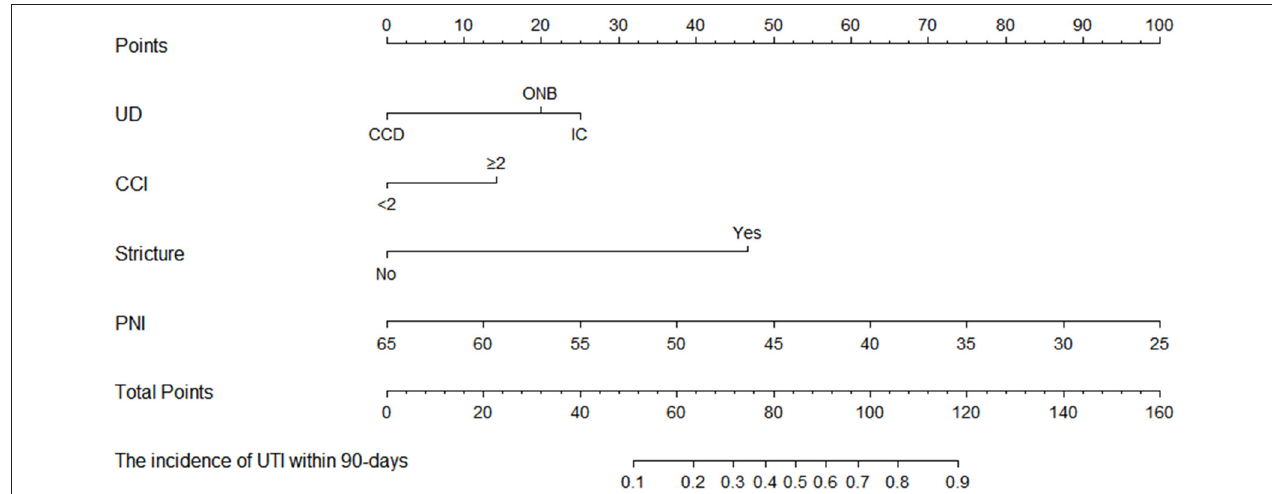
FIGURE 4 | Receiver operating characteristic (ROC) and decision curve analysis (DCA) curve in the training and validation cohort. (A) The ROC cure in the training cohort. (B) The ROC curve in the validation cohort. (C) The DCA cure in the training cohort. (D) The DCA curve in the validation cohort.